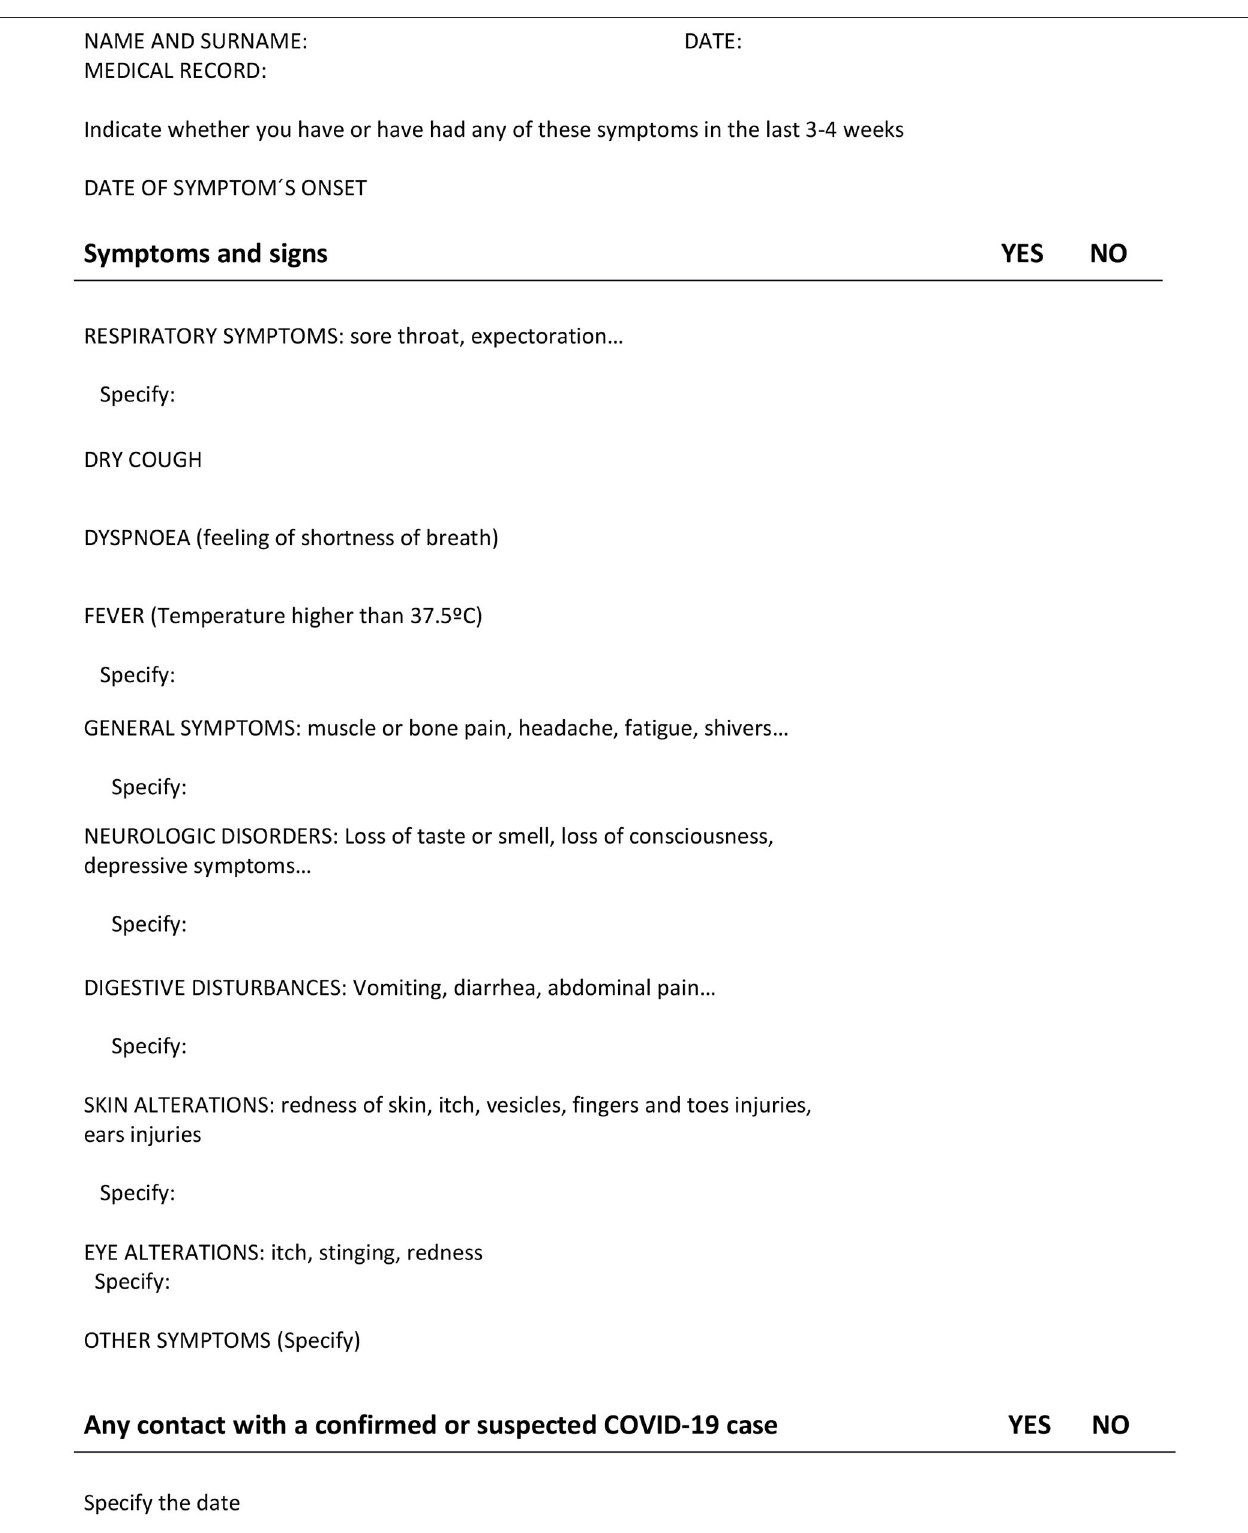
FIGURE 1 | Standardized symptom-based form for screening.